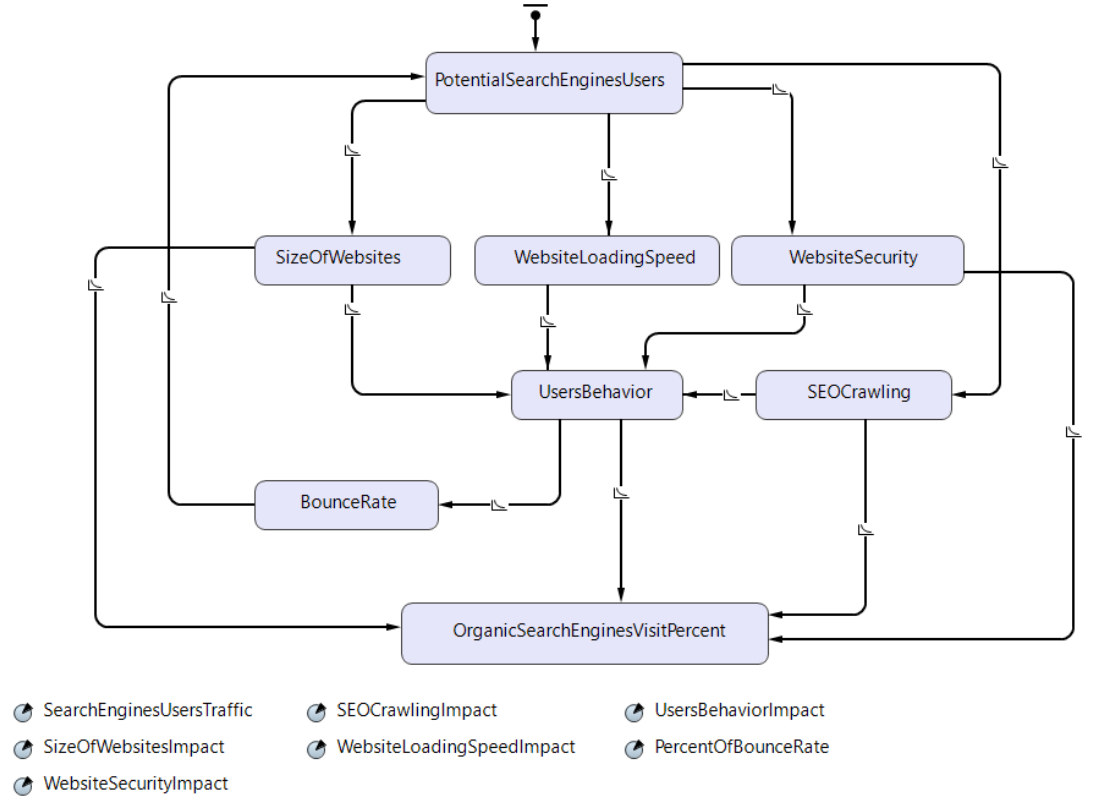
Figure 8. A predictive agent-based model for optimization of the organic search engine visit percentage and decrease of the bounce rate.